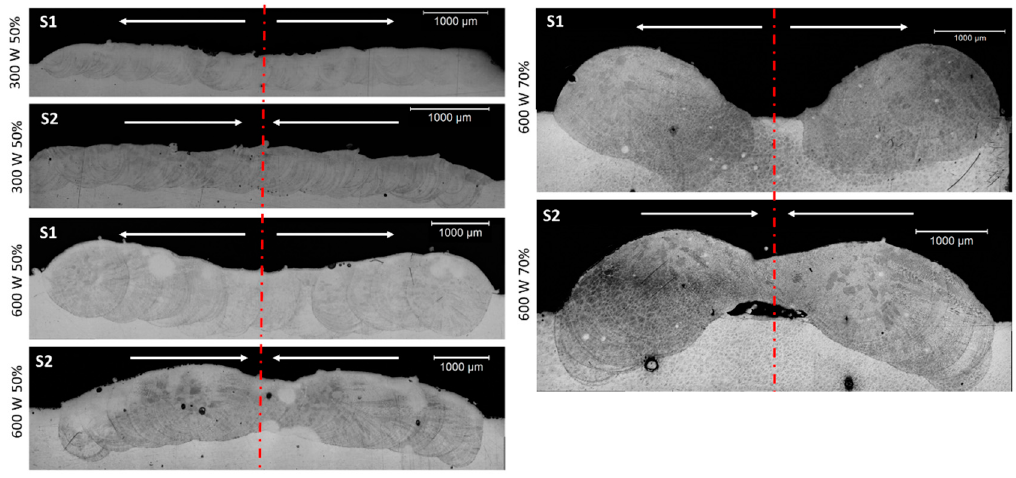
Figure 6. Optical micrographs of circular overlap samples.